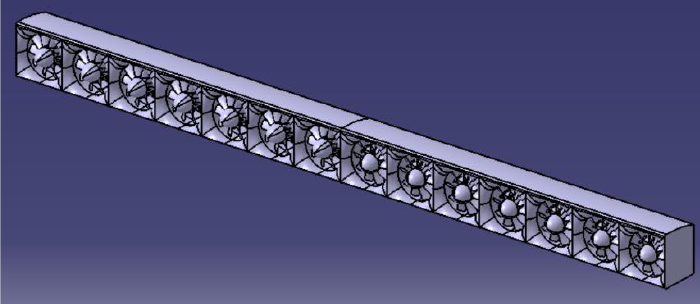
Figure 3 . CAD model of the DEP system. Figure 3. CAD model of the DEP